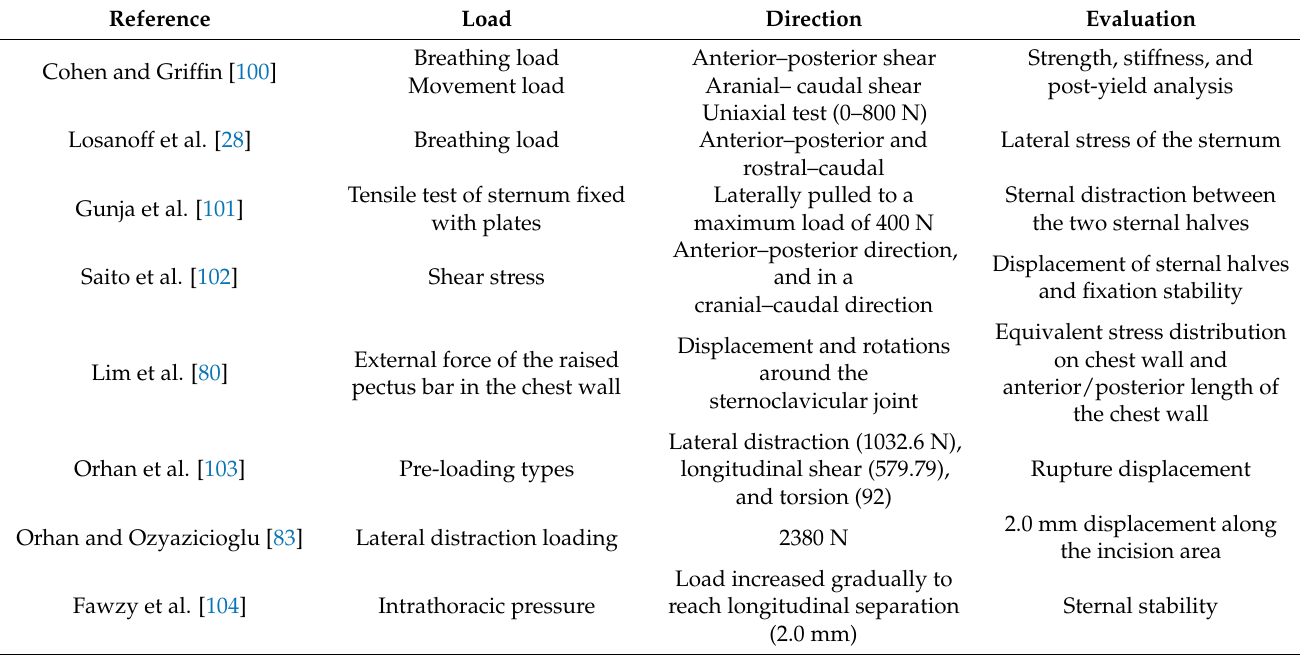
Table 8. Overview of the sternal loads reviewed for modeling the sternal